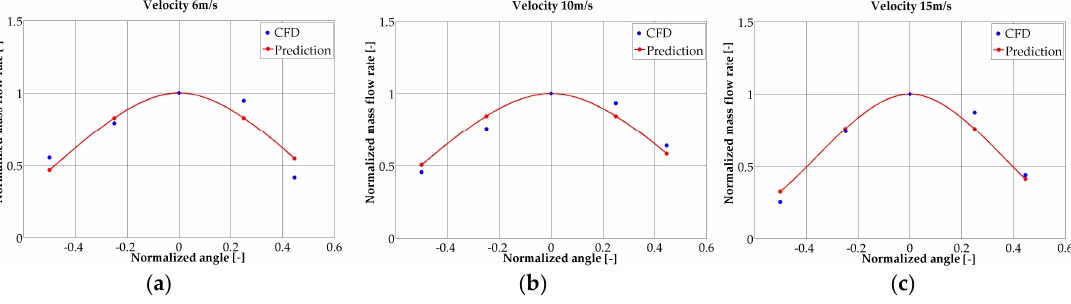
( c ) Figure 16. Vectors and velocity magnitude on the window opening for (a) 6 m/s, (b)10m /s, (c)15 m/s wind speed, with a wind direction of 215 o . The fitted function depends on the type of window opening, building dimensions, and wind conditions. Thus, in the current study the best fit to the normalized data is achieved by using the Gaussian function provided by Equation (9): f(x) = ae (cid:2879) ((cid:2934)(cid:2879)(cid:2912)) (cid:3118) (cid:2870)(cid:2913) (cid:3118) (9) The constants a and b are selected equal to 1 and 0, respectively, in order for the Gaussian curve